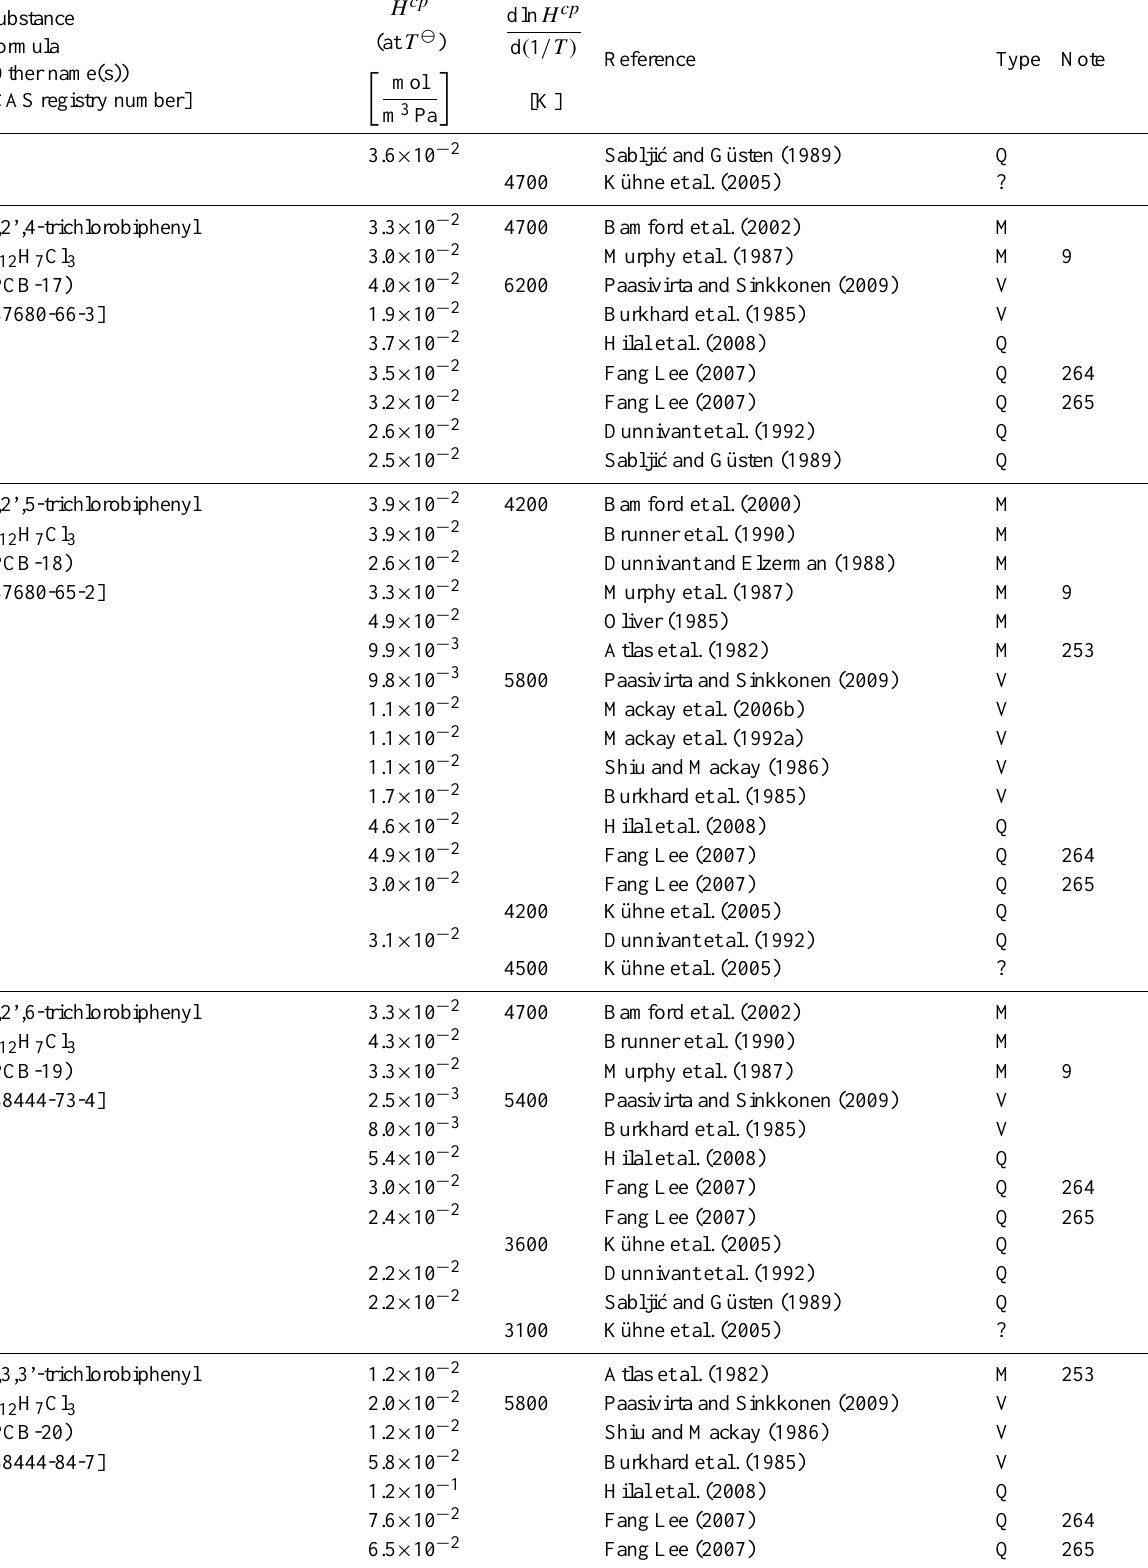
Table 6: Henry’s law constants for water as solvent